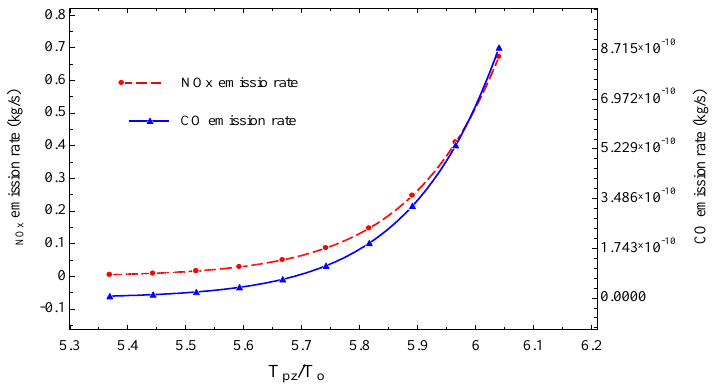
Figure 5. Effect of 𝑇 𝑝𝑧 𝑇 0 ⁄ ratio on formation rates of NOx and CO.